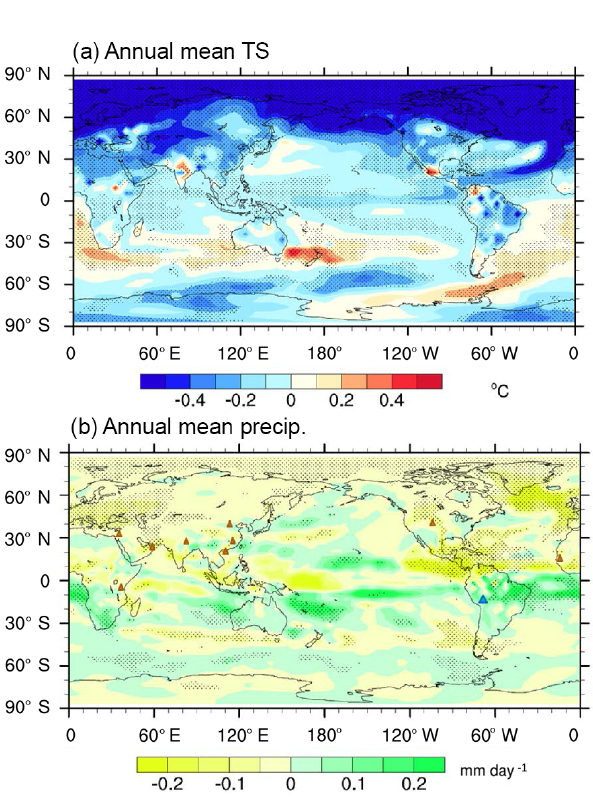
Figure 3. Spatial distribution of the annual mean (a) surface tem- perature (TS) and (b) precipitation differences between the cold pe- riods and warm periods derived from the TraCE-ALL run. Those regions which were significant above the 95% confidence level are dotted. Triangles in (b) denote the dry (orange) and wet (blue) con- ditions documented in the records, including the following sites: Kilimanjaro (3 ◦ 04.6 (cid:48) S, 37 ◦ 21.2 (cid:48) E) (Thompson et al., 2002), Dead Sea (Yechieli et al., 1993), Gulf of Oman (24 ◦ 23.4 (cid:48) N, 59 ◦ 2.5 (cid:48) E) (Cullen et al., 2000), Lake Rara (29 ◦ 32 (cid:48) N, 82 ◦ 05 (cid:48) E) (Nakamura et al., 2016), Maar Lake in Huguangyan (21.15 ◦ N, 110.29 ◦ E) (Liu et al., 2000), Daihai Lake (40.58 ◦ N, 112.7 ◦ E) (Peng et al., 2005), Poyang Lake (29.15 ◦ N, 116.27 ◦ E) (Ma et al., 2004), eastern Col- orado Dunes (40 ◦ 20 (cid:48) N, 104 ◦ 16 (cid:48) E) (Forman et al., 1995), Lake Titicaca (12.08 ◦ S, 69.85 ◦ W) and Lake Guiers (16.3 ◦ N, 16.5 ◦ W) (Marchant and Hooghiemstra,